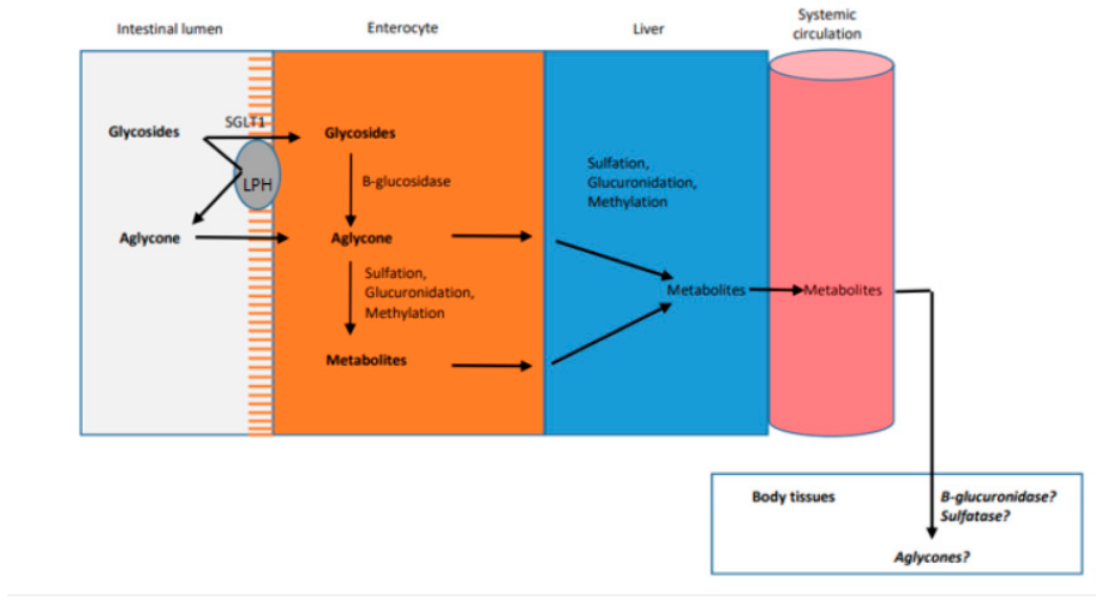
Figure 3. Overview on the absorption and metabolism of quercetin glycosides in the small intestine according to [80]. The administration of 151 mg quercetin-3-glucoside capsule and 154 mg quercetin-4 (cid:48) - glucoside capsule resulted in similar peak plasma concentrations of 5.0 µ M and 4.5 µ M, respectively. A comparison of the absorption of quercetin from different food matrices (225 µ moles from onion, 325 µ moles from applesauce with peel, and 331 µ moles in form of rutin capsule) yielded the highest absorption rate of 0.74 µ M for fried onions and 0.3 µ M for the other quercetin sources. Moreover the accumulation of quercetin conjugates in plasma could be shown following the periodic ingestion of onion. Hence the concentration of glucuronide and sulfate metabolites increased from 0.04 µ M to 0.63 µ M after the